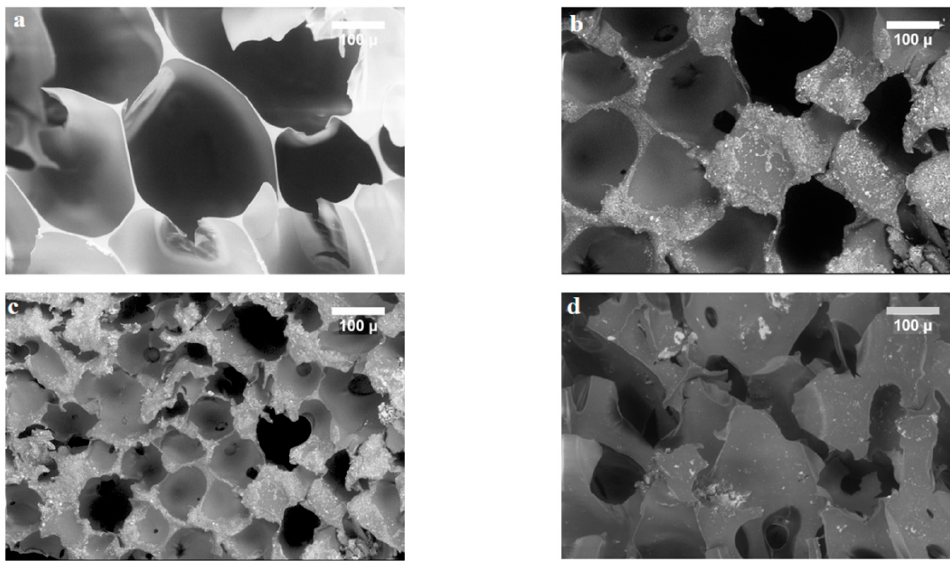
Figure 7. The SEM micrographs for ( a ) PU, ( b ) P 1 MR20, ( c ) P 2 MR20, and ( d ) P 3 MR20. The cell density for neat PU was 3.2 × 10 9 cells/cm 3 , whereas for the other composite foams, it was 1.1 × 10 10 and 3.5 × 10 10 cells/cm 3 for P 1 MR20 and P 2 MR20, respectively. It was noticed that the cell density increased when the filler loading increased. This could